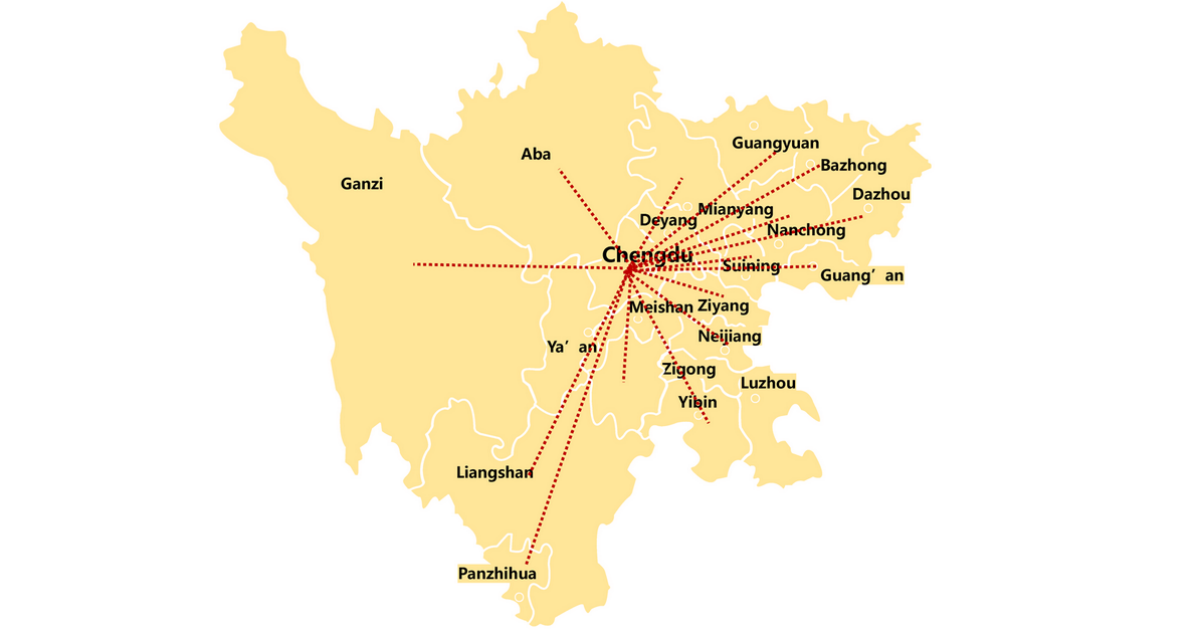
Figure 2. The 5G telemedicine network of Sichuan Province, China, established during the coronavirus disease (COVID-19) pandemic. This system makes use of the newly established China Telecom 5G Dual Gigabit infrastructure and currently covers all designated hospitals for COVID-19 of Sichuan Province (5 provincial-level, 24 municipal-level, and 179 county-level hospitals), with the West China Hospital of Sichuan University (WCHSU) as the central node. The median distance between a spoke hospital and WCHSU is 319 km (range 20 to 1191 km).